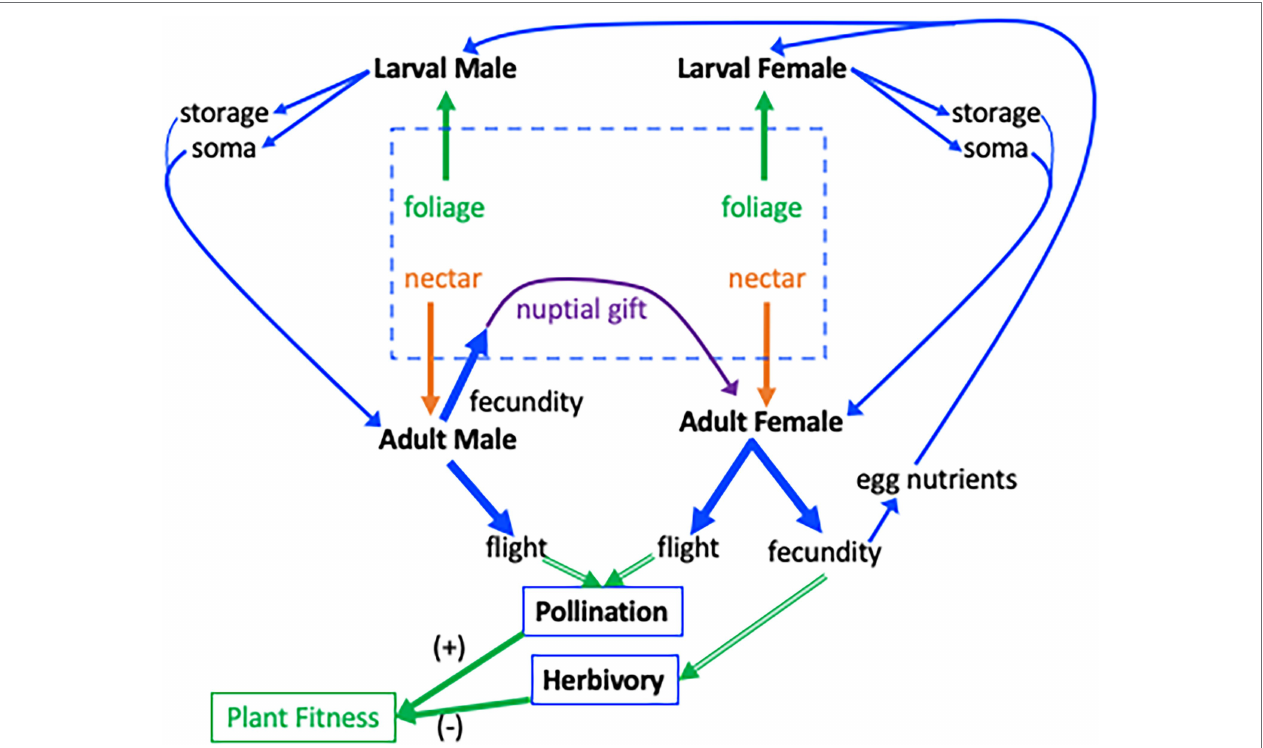
FIGURE 1 | Interaction between a plant and a Lepidopteran that is an herbivore as a larva and a pollinator as an adult. The central dashed box indicates resource pools to the insect. Host-plant foliage is the resource for larvae (green arrows from dashed box), nectar is a resource for adults (orange arrows), and nuptial gifts are a resource given to the female by the male (purple arrow). For simplicity, only resources relevant to flight–fecundity trade-offs are shown and allocation to other functions such as maintenance, are omitted. Blue lines indicate resources and green lines indicate effects on plant fitness. Larvae consume foliage for nutrient storage and growth (soma; strait blue arrows at top) which are available as resource pools in the adult following metamorphosis (curved blue arrows). Adult Lepidoptera can allocate resources to flight or fecundity (thick blue arrows). The consequences of flight–fecundity allocation decisions to the plant (double-lined green arrows) through herbivory and pollination are indicated by the thick green arrows. Allocation of resources to fecundity by males and females reduces plant fitness, green arrow ( − ), via herbivory. Allocation of resources to flight increases plant fitness, (+) green arrow, through pollination. Eggs produced by male allocation to nuptial gifts, and female allocation to fecundity, produce the next generation of herbivores (rightmost blue